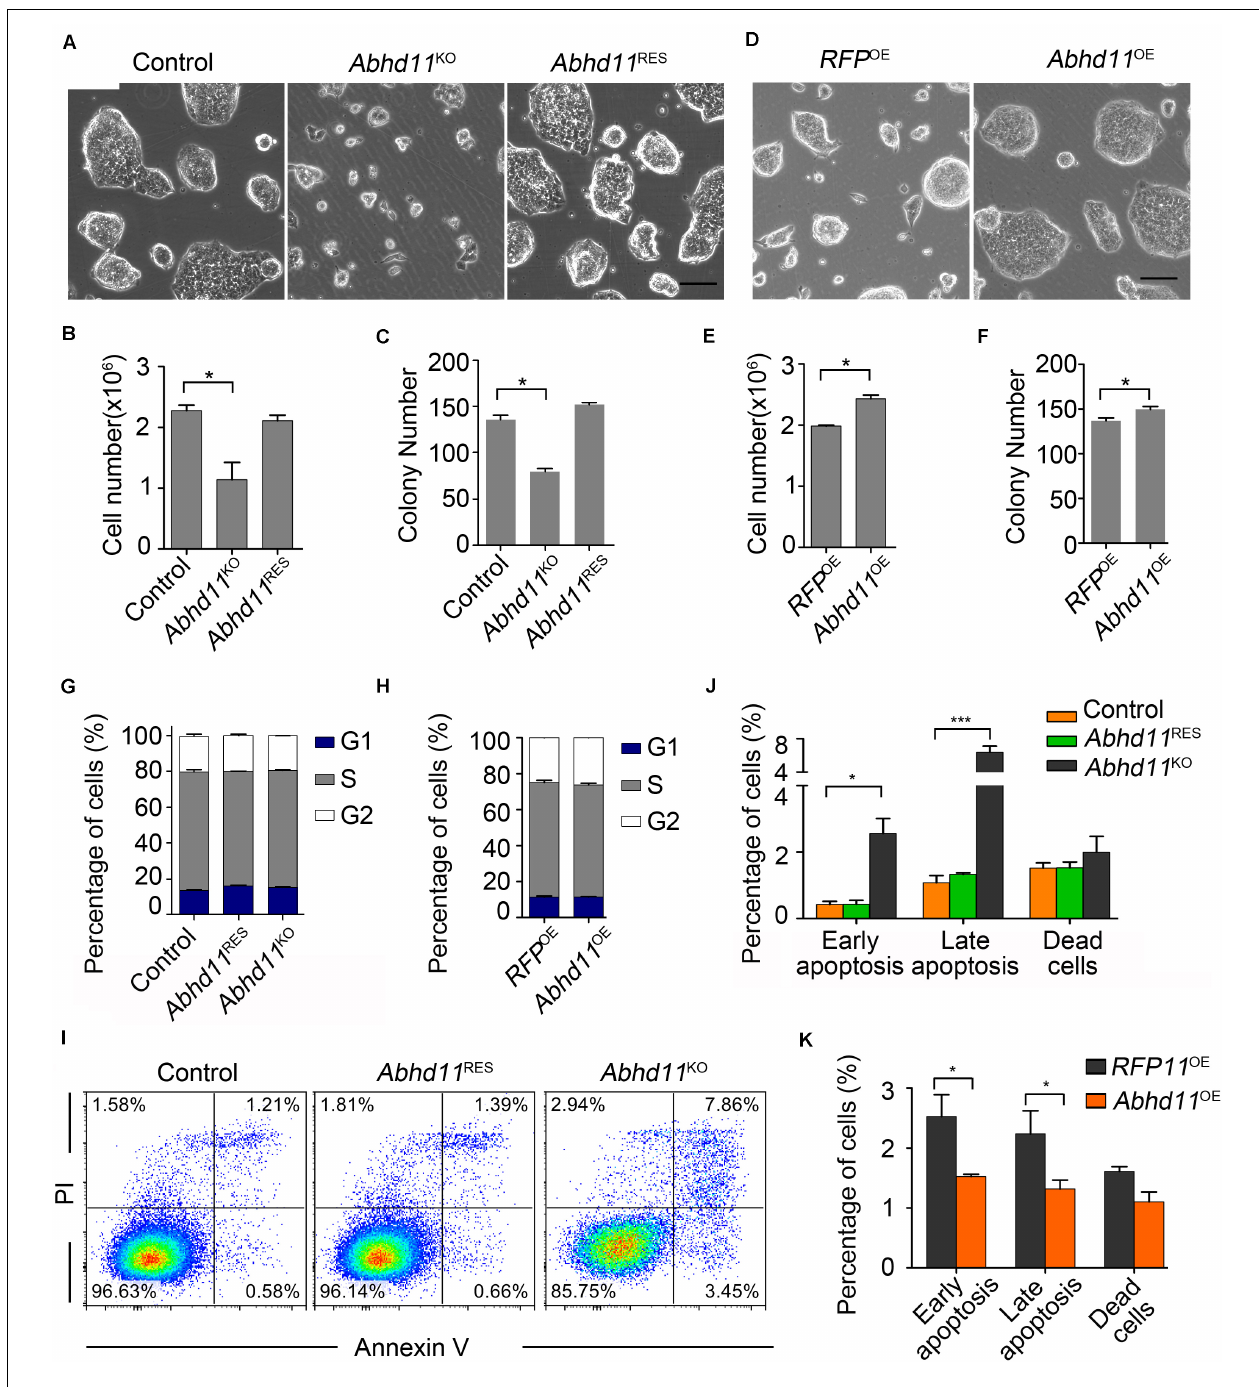
FIGURE 2 | ABHD11 contributes to the expansion of ESCs. (A) Representative morphology of colonies formed by control, Abhd11 KO , and Abhd11 RES ESCs. Scale bar, 100 µ m. (B) Cell growth of control, Abhd11 KO , and Abhd11 RES ESCs. (C) Quantitative analysis of colonies formed by control, Abhd11 KO and Abhd11 RES ESCs. (D) Representative morphology of colonies formed by the indicated cells. Scale bar, 100 µ m. (E) Cell growth of RFP OE ESCs and Abhd11 OE ESCs. (F) Quantitative analysis of colonies formed by RFP OE and Abhd11 OE ESCs. (B,E) Cells (1 × 10 5 cells/well in 12-well plates) were cultured for 2 days and cell numbers were counted. (C,F) Cells were plated at clonal density (200 cells/well in 12-well plates) and cultured for 5 days. (G,H) Proportions of the cells in G1, S and G2 phase. Cells were stained with propidium iodide (PI) and analyzed by fluorescence-activated cell sorting (FACS). (I) Apoptosis of the indicated cells was measured by FACS with Annexin-V and PI staining. One of three experiments with similar results was shown. (J,K) The fraction of the indicated cells labeled for early apoptosis (Annexin V + PI − ), late apoptosis (Annexin V + PI + ), and dead cells (Annexin V − PI + ). Data in panels (B,C,E–H,J,K) were represented as mean ± s.d.; n = 3. * p < 0.05, *** p <